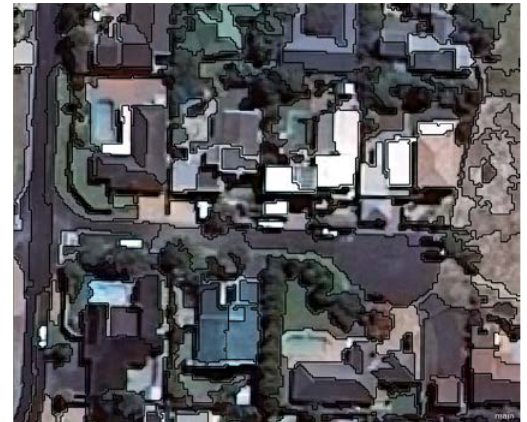
Figure 5a: Image segmentation (Level 2, scale: 100)